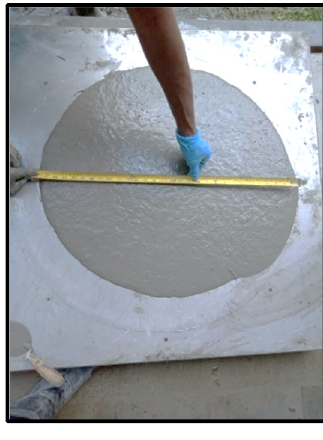
Figure 2. Freshly mixed SC-GORECC.